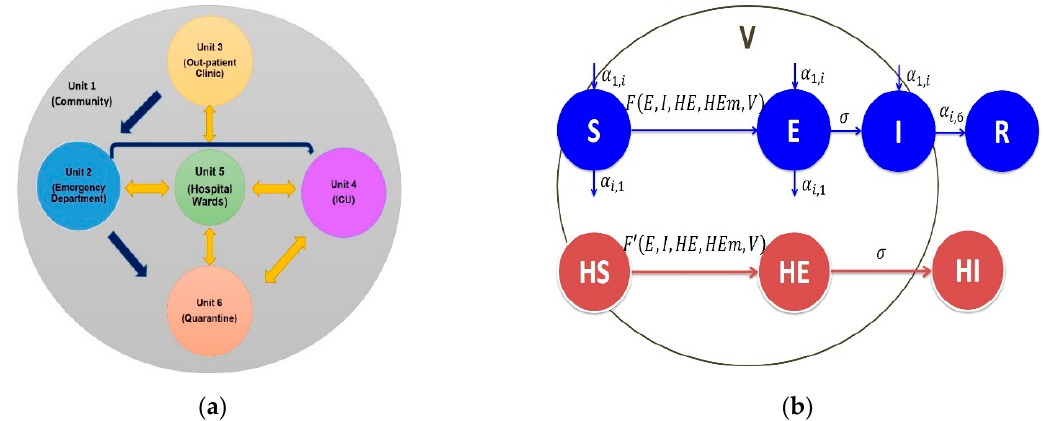
Figure 1. Schematic illustrations of the model. ( a ) Hospital ward model showing the possible movements between wards in the health care facility. ( b ) Hospital ward model movement of people between wards within the health care facility. The parameters α i , j are the transition rates from unit i to unit j . The functions F and F (cid:48) are the forces of infection imposed on susceptible patients and health care workers (HCWs), respectively. The mobile health care workers follow the same transitions between the disease compartments as other health care workers. The rate of isolation α i ,6 = : α 6 is assumed to be the same for any unit i . Finally, σ is the rate at which exposed people become symptomatic.